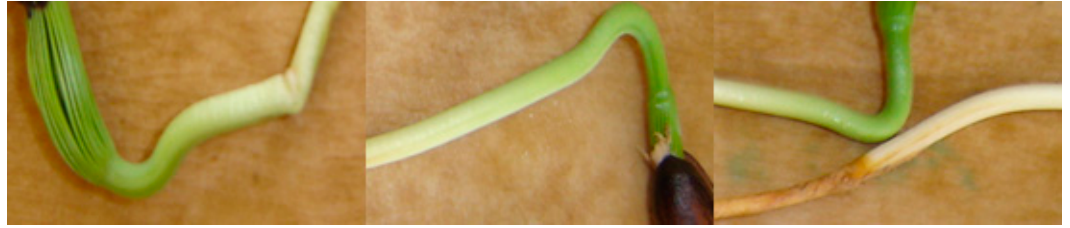
Figure 8. Pine seedlings from seeds irradiated with UV-B and UV-C.